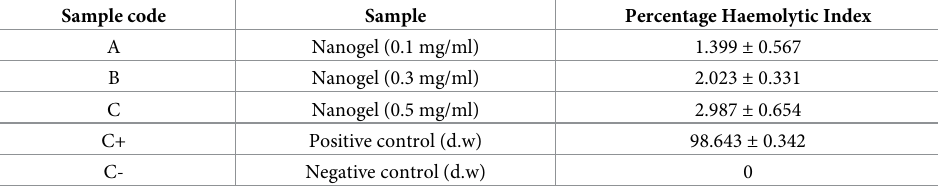
Table 7. Blood haemolysis index after treatment with nanogel samples for 3 h at 37˚C.